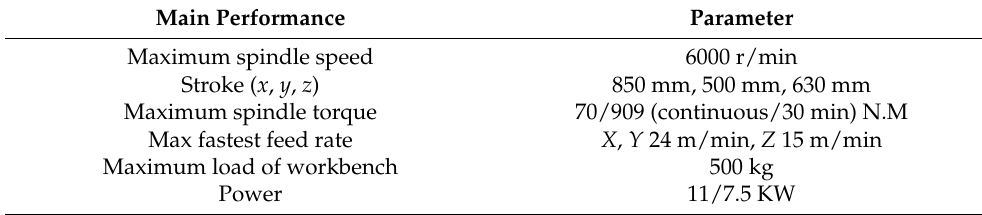
Table 1. TH5650 Vertical machining center